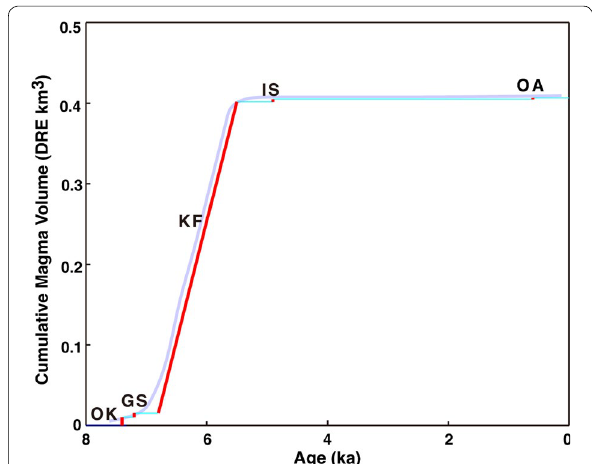
Fig. 16 Cumulative magma volume erupted from Azuma-Jododaira Volcano. A red solid line represents an eruption event. A lilac solid line shows a tendency of the eruption rate. OK GS Goshikinuma unit; KF = unit (Yamamoto 2005)